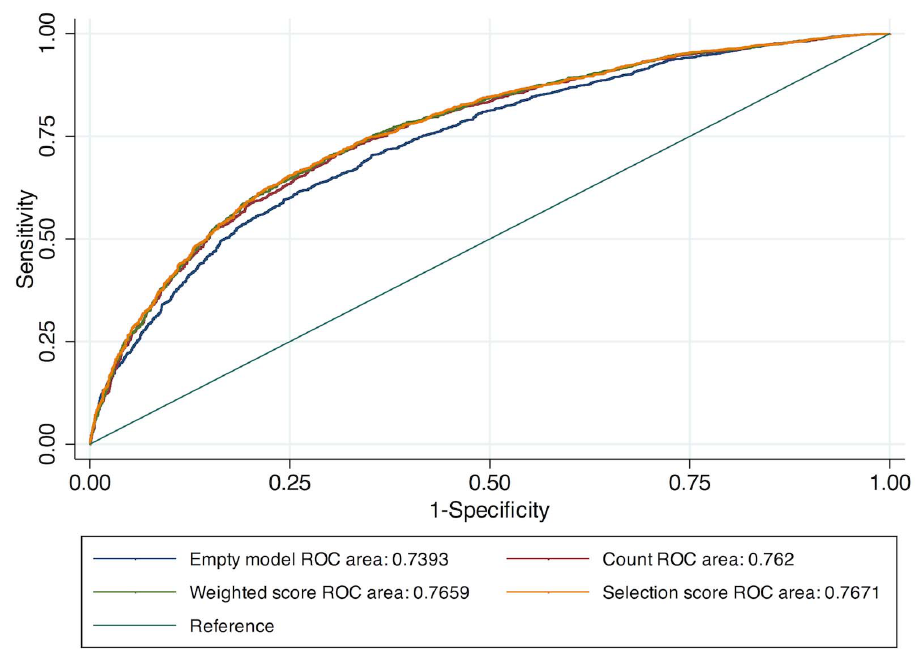
Fig. 1. Areas Under the Curve (AUCs) for discrimination of comorbidity scores with regards to primary outcome SGRQ. All three scores compared to ‘‘empty’’ model (including age, gender, race, FEV1, pack- years smoked and current smoking status). ROC for empty model is 0.7393.